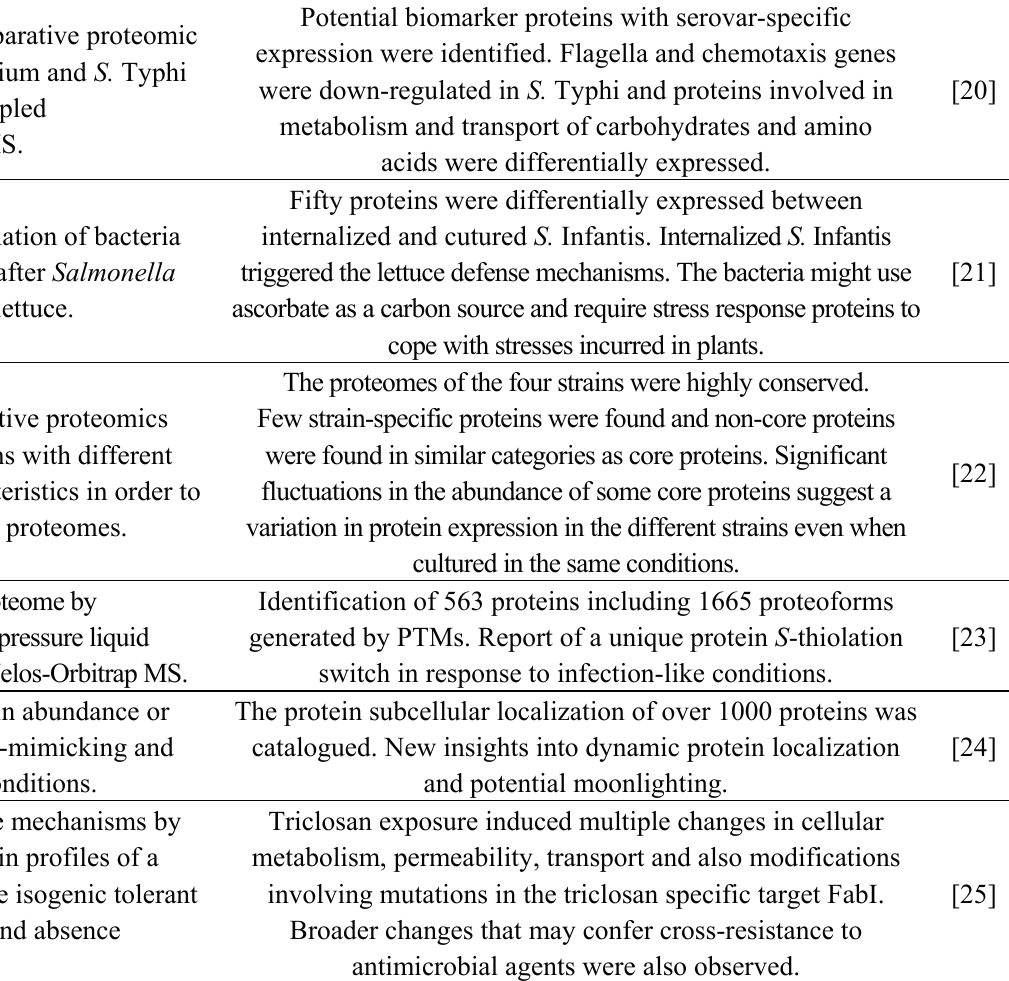
Table 1. List of Salmonella serotypes studied at the proteomic level with a short description of the main purpose and findings of each study.